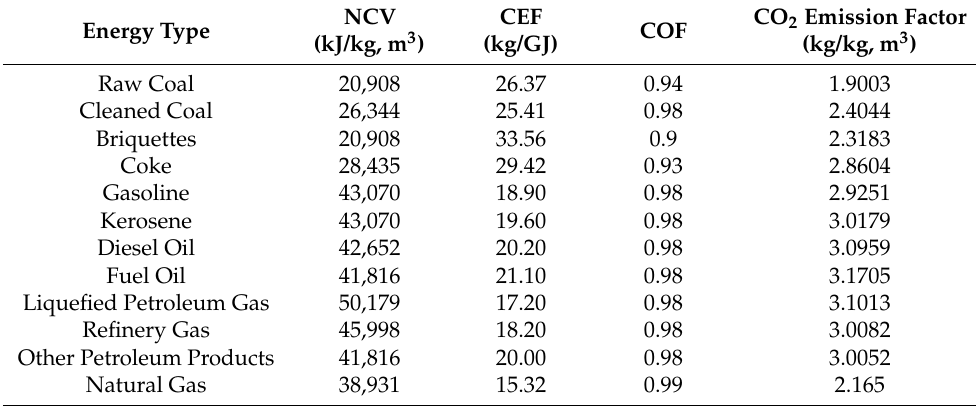
Table 1. Energy conversion factors and carbon emission coefficients. Energy